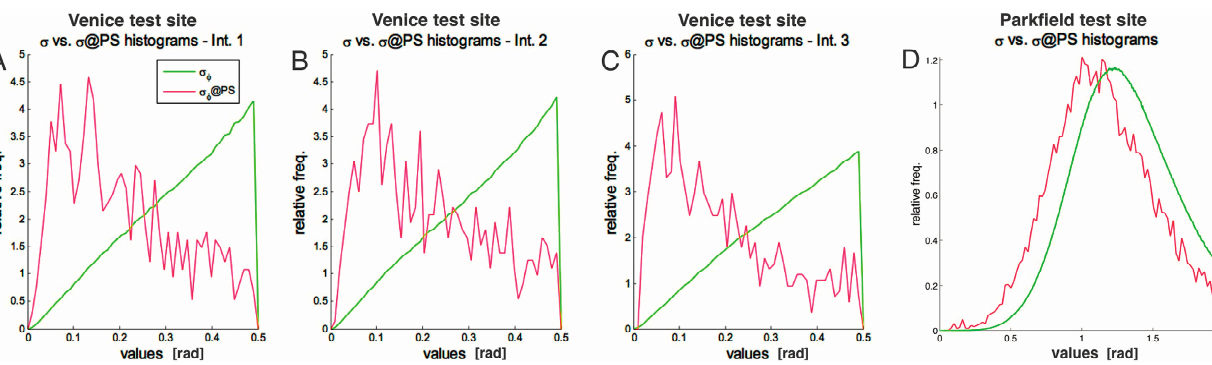
Figure 6. Normalized histograms of MCA σ for all the pixels (green lines), and for those Φ spatially coincident with PS (red lines) for interferograms ID-1 in ( A ), ID-2 in ( B ), and ID-3 SB in ( C ). Panel ( D ) refers to the same selection on the Parkfield test site (see text for